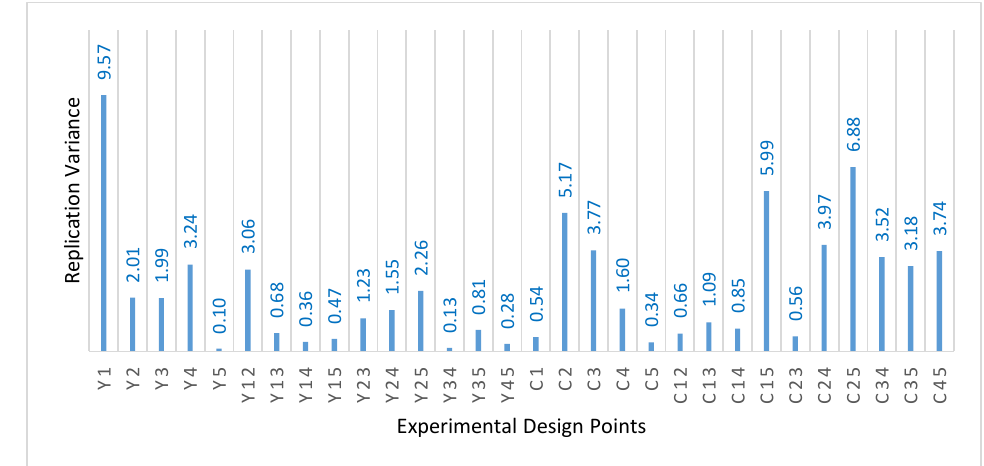
Experimental Design Fig. 4. The Replication Variance of the Experimental Test Result.